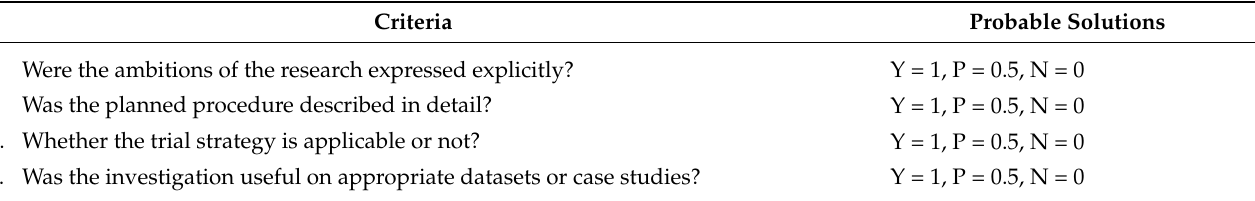
Table 1. Four basic quality assessment criteria.